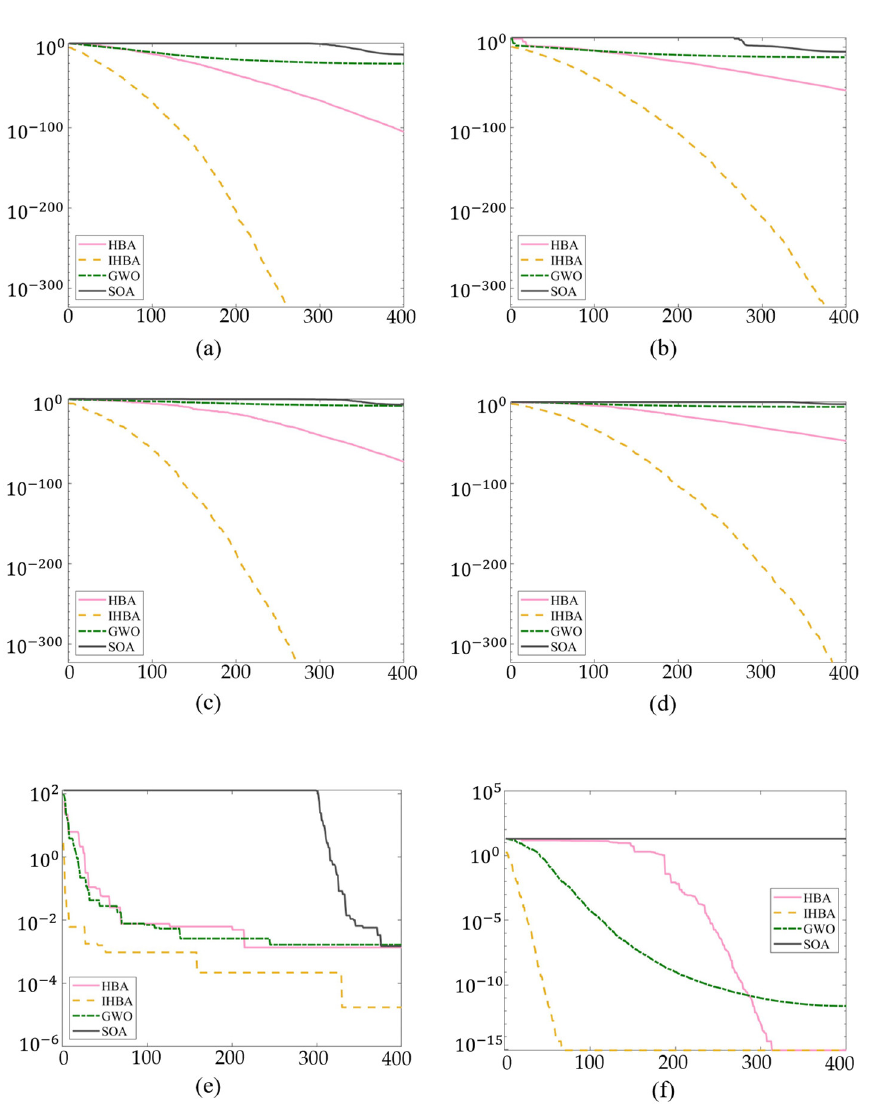
Figure 6. (a): Convergence curve of Figure 6. ( a ): Convergence curve of f 1 ( x ) ; ( b ): Convergence curve of f 2 ( x ) ; ( c ): Convergence curve ( ) f x ; (b): Convergence curve of 1 curve of of f 3 ( x ) ; ( d ): Convergence curve of f 4 ( x ) ; ( e ): Convergence curve of f 5 ( x ) ; ( f ): Convergence curve ( ) f x ; (d): Convergence curve of ( ) f x ; (e): Convergence curve of 3 4 of f 6 ( x ) gence curve of ( ) f x 6 Table 2. Test results of the algorithm.